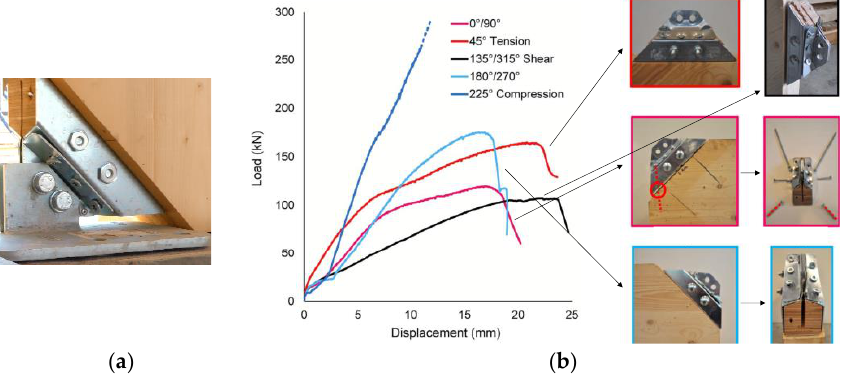
Figure 6. X-RAD system: ( a ) HD connector (photo credit: Rothoblaas, reprinted with permission); ( b ) force – displacement curves and failure modes (photo credit: Andrea Polastri, reprinted with permission).